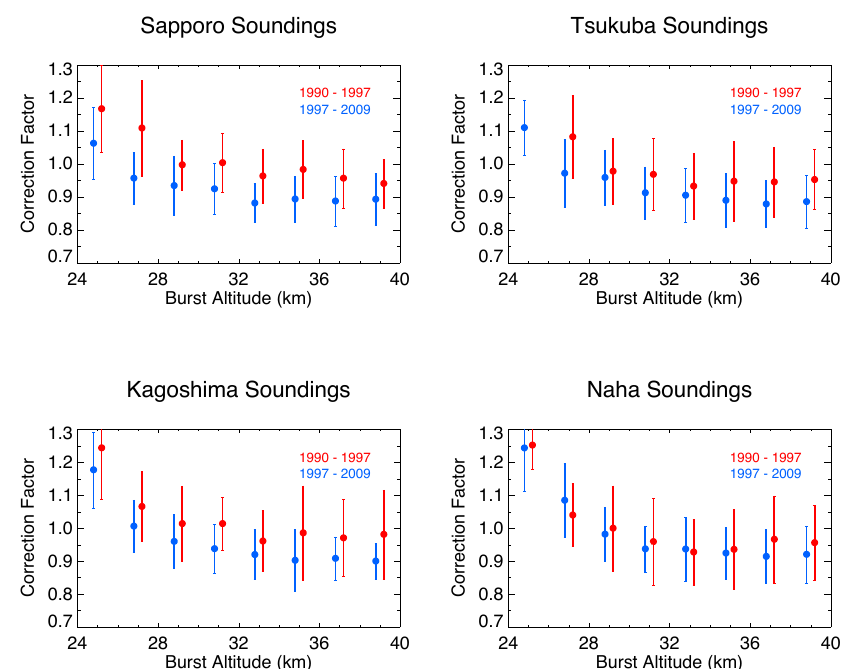
Fig. 3a. CFs reported in the WOUDC data files as a function of burst altitude for ozonesonde profiles and columns at the Japanese stations. Data are divided in 2-km bins by burst altitude and divided temporally from 1990–1997 (KC-79 sondes) and 1997–2009 (KC-96 sondes). The error bars represent one standard deviations.